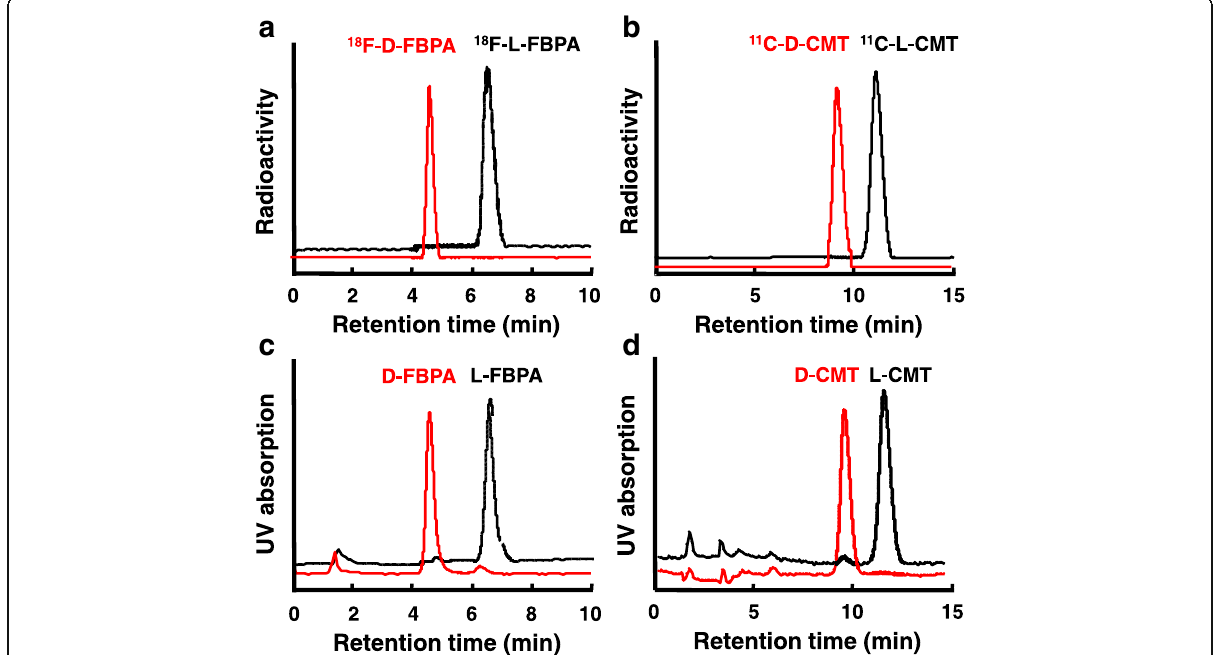
Fig. 1 Analyses of enantiomeric purities of L- and D-isomers of 18 F-FBPA ( c ) and 11 C-CMT ( d ) used in PET measurements. The enantiomeric purity of each compound was analyzed on a CROWNPAK CR(+) column using an elution solution of perchloric acid (pH 2.0) at a flow rate of 2 mL/min. The identification of each compound was conducted by comparing the elution time to each corresponding authentic standard compound of L- and D-FBPA ( a ) and L- and D-CMT ( b